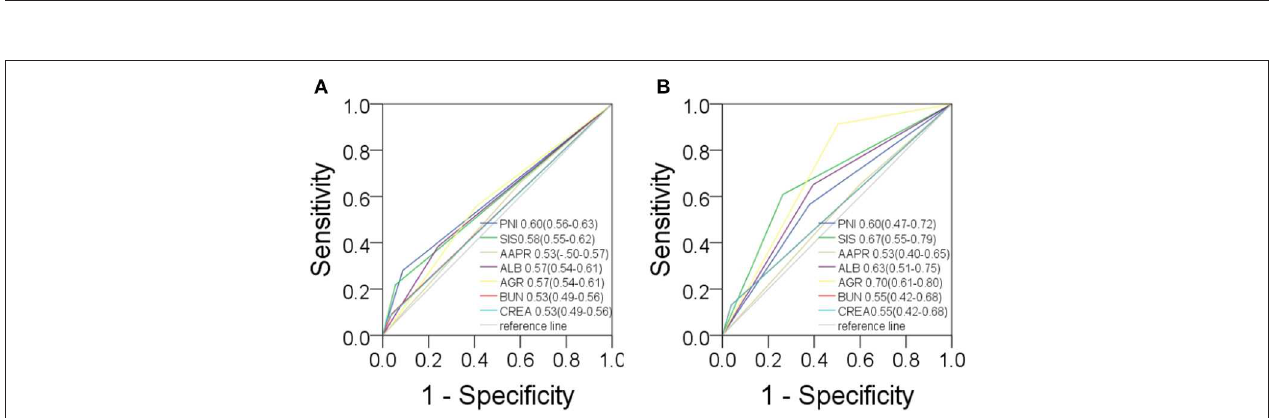
FIGURE 2 | Predictive values in NPC. For diagnosis (A) and prognosis (B) of PNI, SIS, AAPR, ALB, AGR, BUN, CREA.